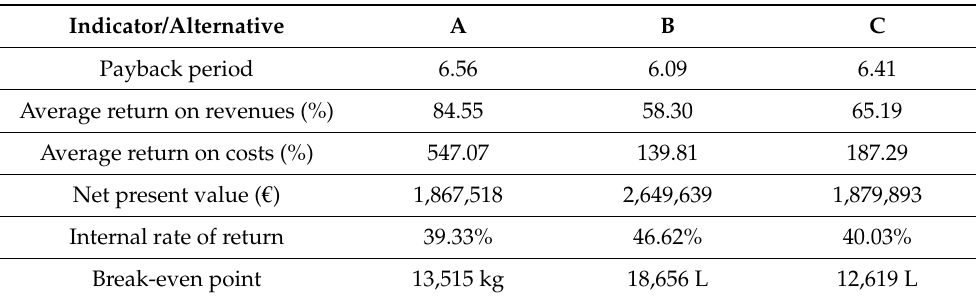
Table 2. Resultant indicators of the economic efficiency of investment—black chokeberry (intensive cultivation